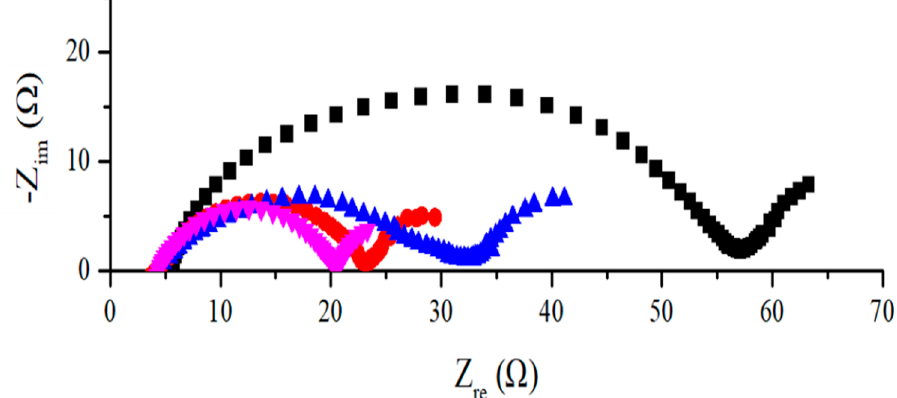
Figure 9. Electrochemical impedance spectra of anode before discharge/charge cycling experiments measured from four sets of anodes made of (black square) silicon flakes, (red dots) silicon flakes coated with an RF carbon layer, (blue triangle) silicon flakes coated with SiC, and (pink reverse triangle) silicon flakes with combined SiC and RF carbon coatings.